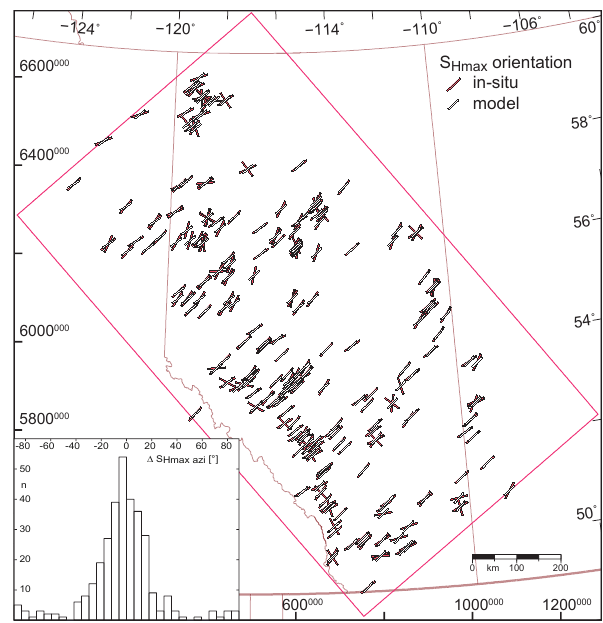
Figure 17. Spatial distribution of the modelled and in situ S Hmax azimuth data. A good fit of the modelled data is reached, except for some suggested misinterpreted data (around ± 90 ◦ ) and system- atic rotations close to the Peace River Arch (56 ◦ N, 118 ◦ W) and close to the Bow Island Arch (50 ◦ N, 114 ◦ W). The map extent is indicated by geographical coordinates (top and right) and by UTM coordinates from zone 11 (left and